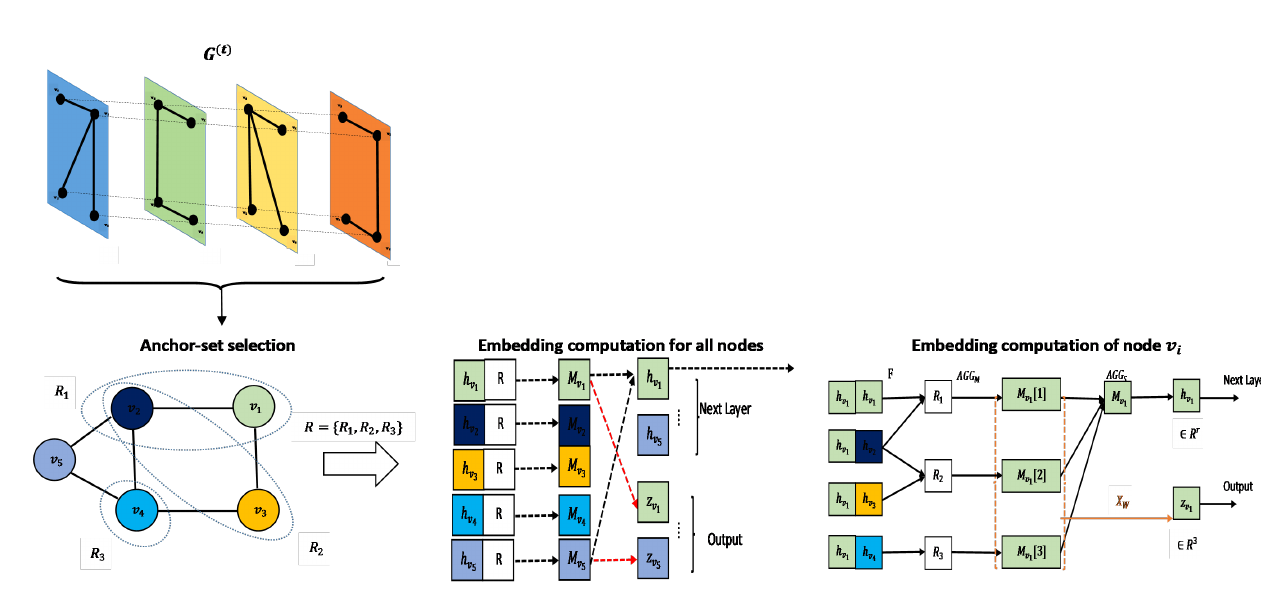
Figure 2. The input to our TMP-GNN layer is a temporal graph G ( t ) , presented as a supragraph and the corresponding supracentrality matrix C ( ω ) . As the first step, anchor sets, a subset of graph nodes with different sizes, are randomly selected according to Bourgain’s theorem [21] (Reproduced with written permission) R = R 1 , R 2 ,..., R J . In order to compute the embedding for v n , feature information of node v n and another node from anchor set R j , is fed into a message computation [ j ] , j = 1,2,.., J corresponding function F with output aggregated through AGG M to produce M v n [ j ] is further aggregated through AGG to R j . Then, M v R to output h v n , which is passed to the next n P-GNN layer. The embedding z v at the last layer is generated by applying the nonlinear σ to the n inner product of M v and weight vector w (You, J., Ying, R. and Leskovec, J., 2019 [15]—modified, n permission is